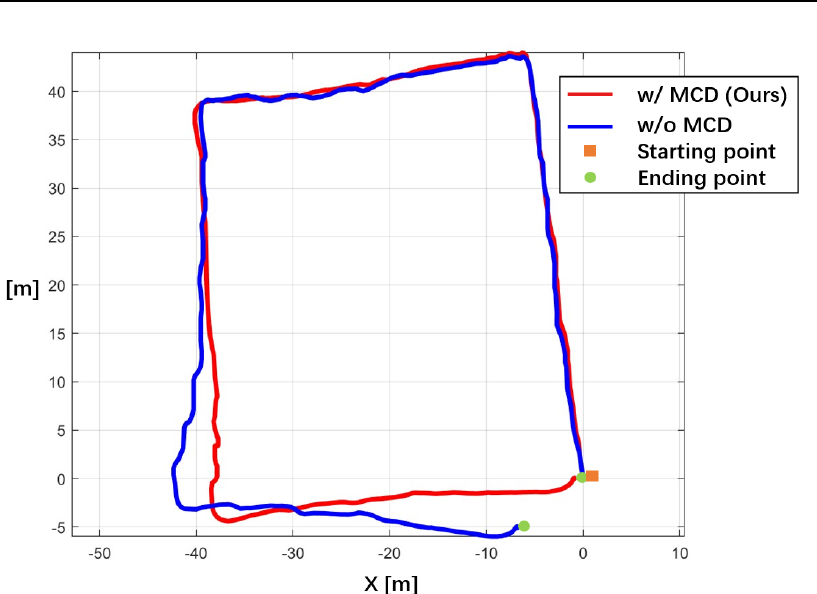
Figure 10. 2D plotting of the fused trajectory with MCD (red line) and without MCD (blue line) of Scenario 1 participant